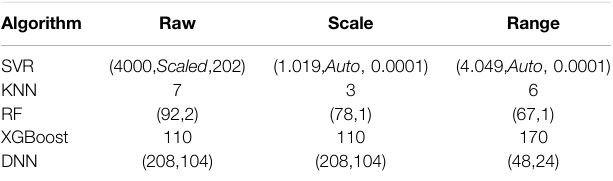
TABLE 4 | Hyper-parameter selection result for each algorithm.